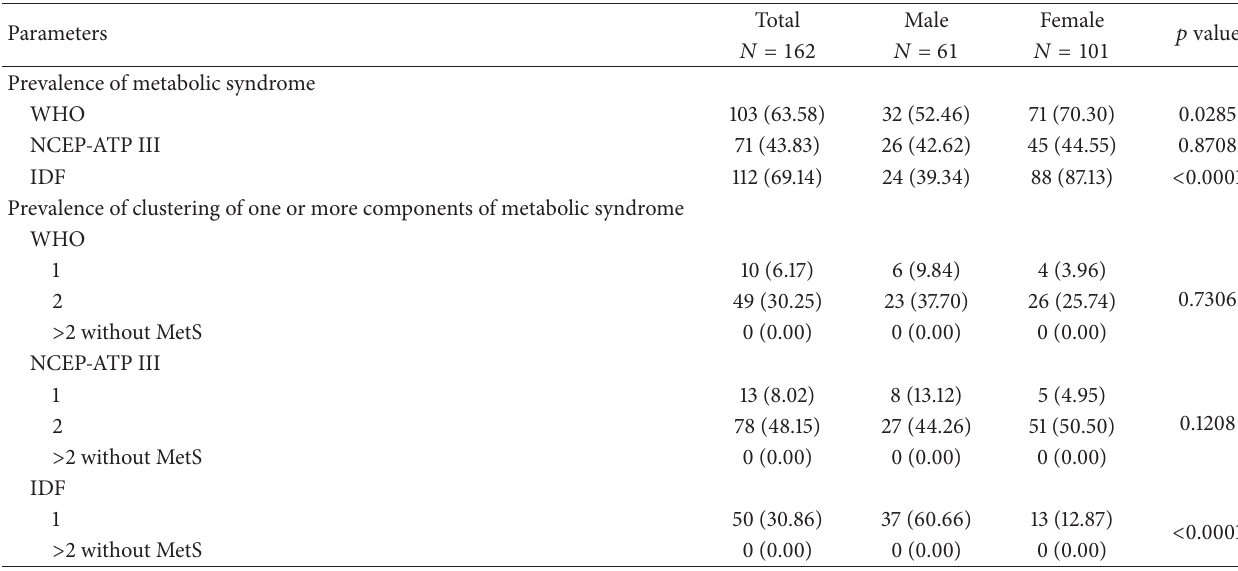
Table 4: Prevalence of metabolic syndrome and metabolic score among the population stratified by gender.